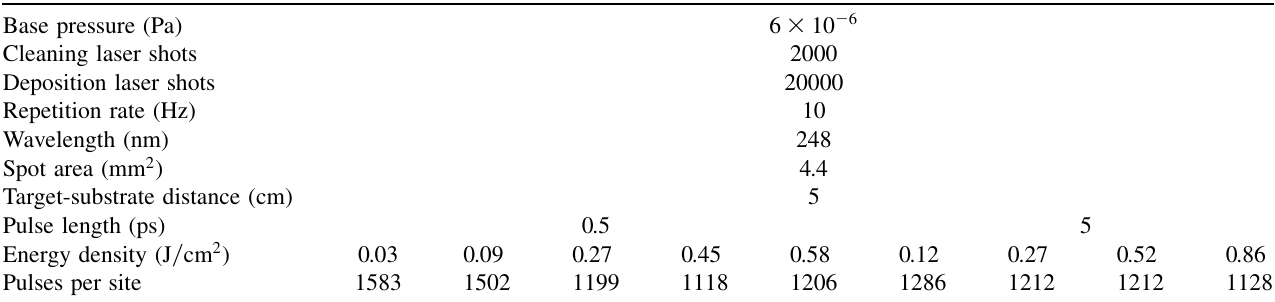
TABLE I. Experimental parameters.